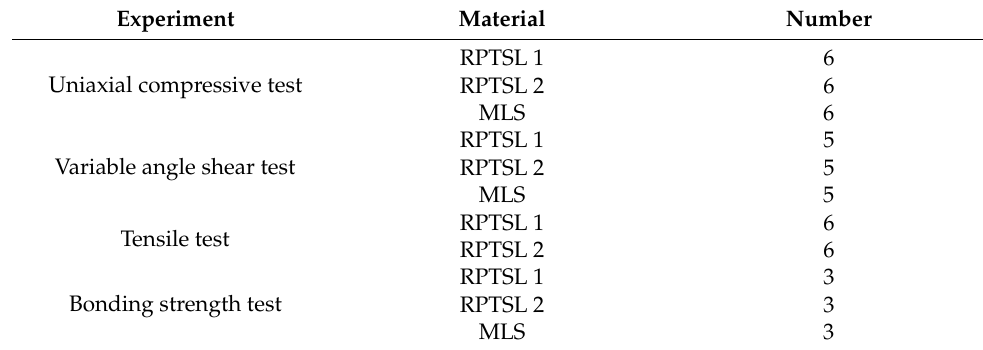
Table 1. Experiment and testing number.